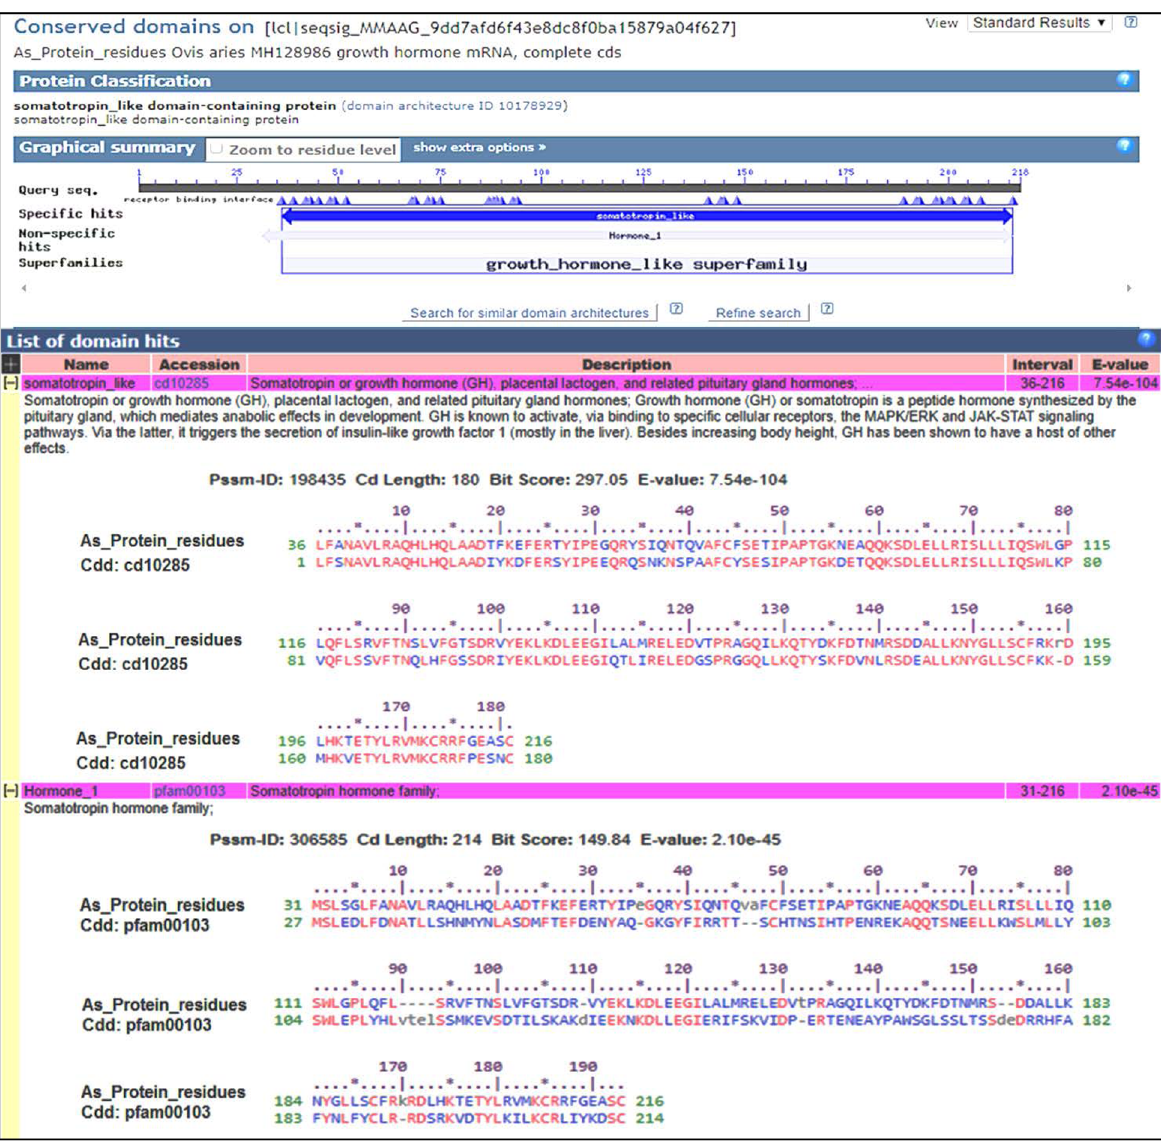
Fig. 10 Conserved domain of As_GH protein